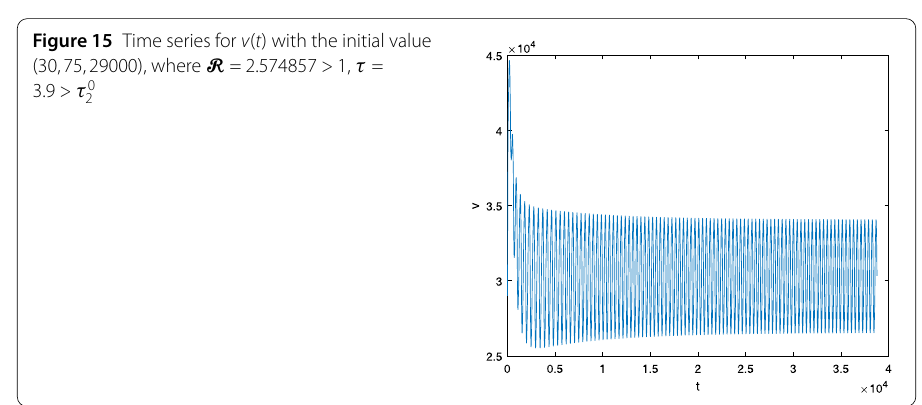
Figure 16 3D phase for x ( t ), y ( t ), and v ( t ) with the initial value (30,75,29000), where R = 2.574857 > 1, τ = 3.9 > τ 0